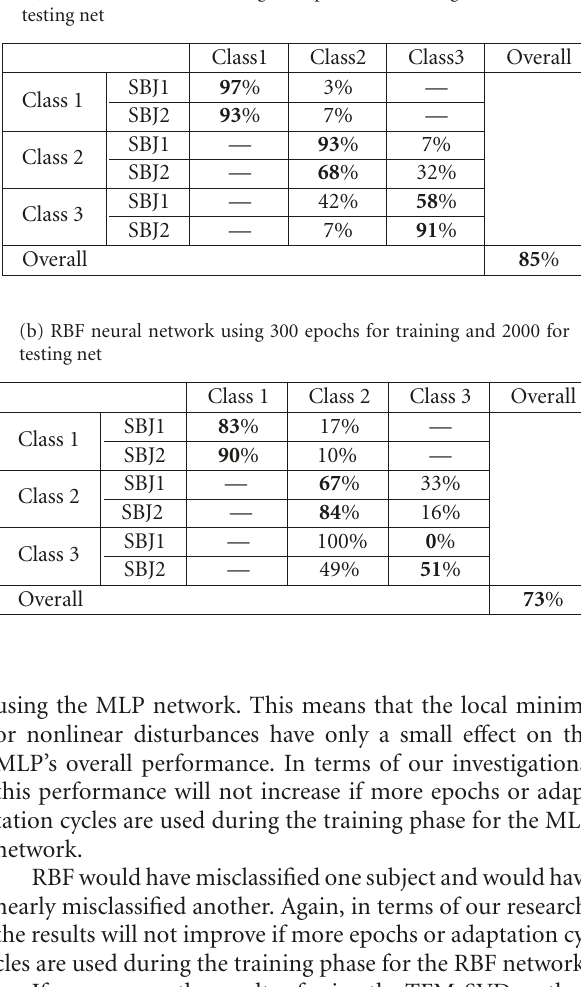
Table 1: Results of the BCG classification using neural networks and BCG cycles in Figure 5. TFM-SVD is used for computing BCG waveform features. SBJ means subject. Every cell shows the correct classification percentage for every class. Class 1: young healthy stu- dents aged between 20–30 years (2 subjects). Class 2: old healthy men aged between 50–70 years (2 subjects). Class 3: two old sub- jects (50–70 years old) with a previous heart infarction. Overall (%): performance computed using randomly selected training and test- ing BCG data of 6